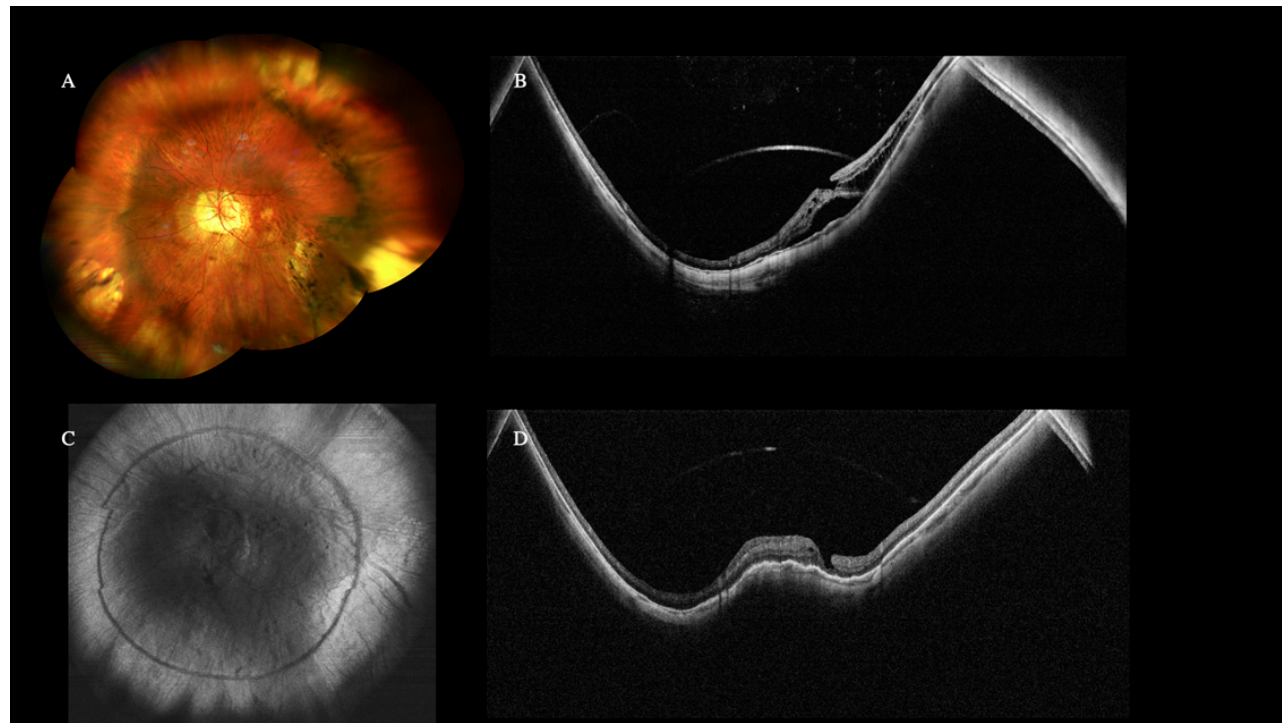
Figure 3. Wide-Field (WF) color fundus retinography of pathologic myopia and posterior staphyloma ( A ). The wide-field optical coherence tomography (WF-OCT) image ( B ) shows the posterior staphyloma and the choroidal thinning in these eyes. Myopic Traction Maculopathy (MTM) stage 3b was diagnosed. The OCT ( C ) projection image shows the staphyloma’s perimeter. The patient underwent a macular buckle that resolved the retinal detachment and the macular schisis ( D ).